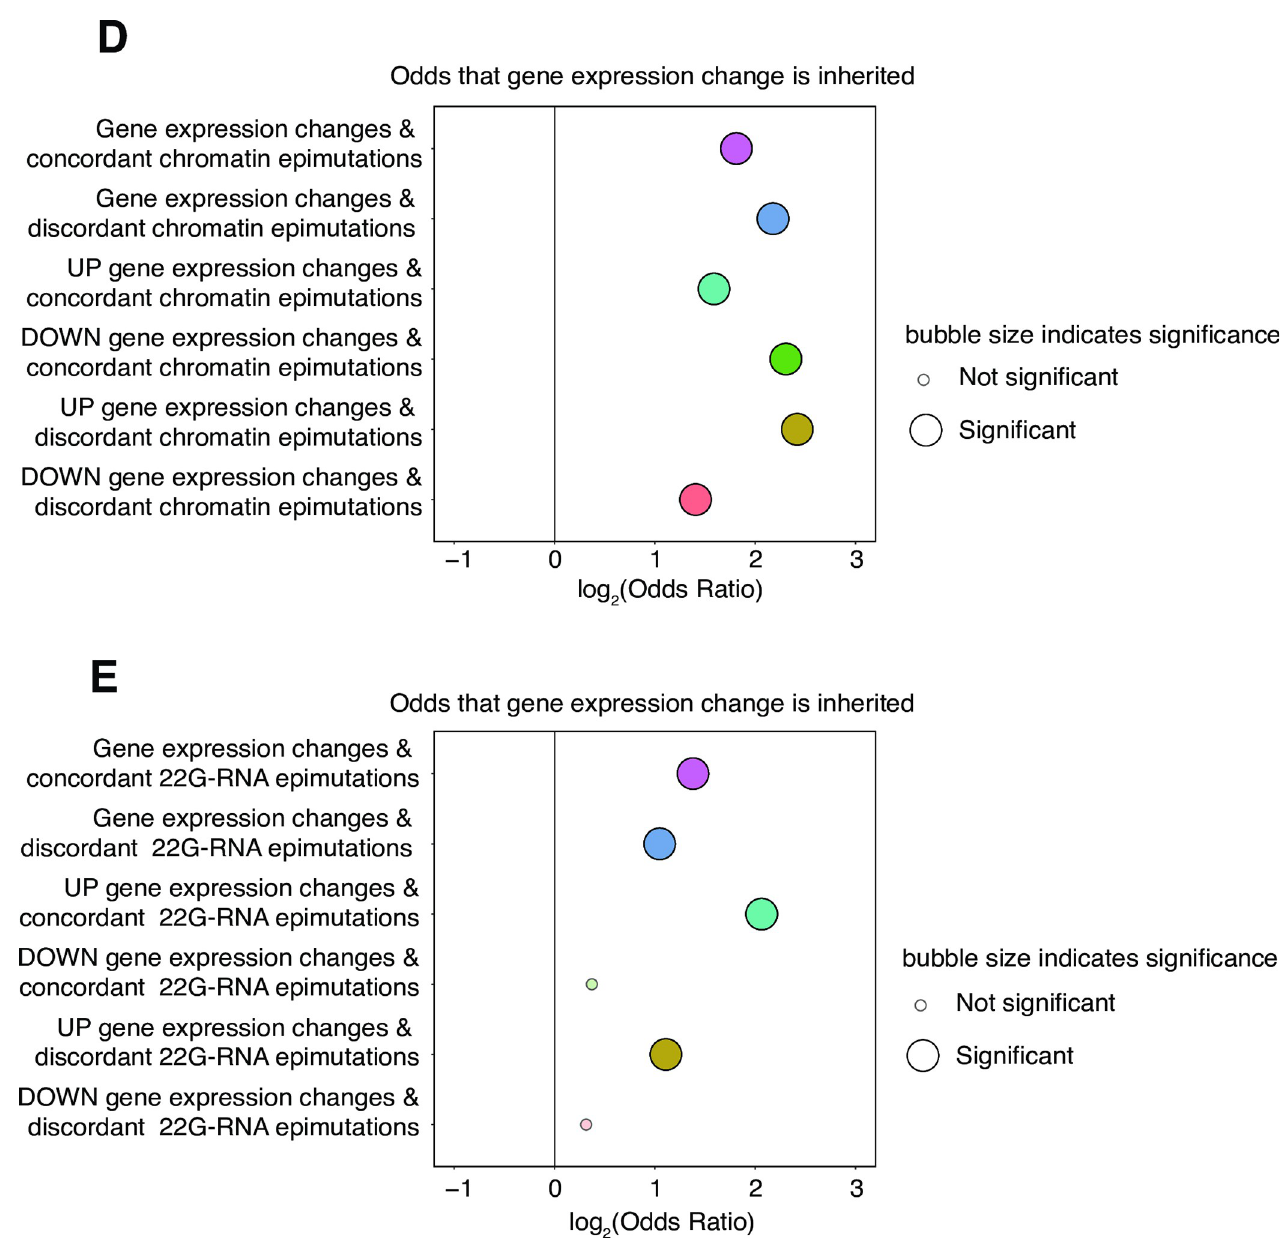
Fig 3. Genes with inherited expression changes are enriched for simultaneous chromatin-based epimutations. A. Chromatin-based epimutations which alter accessibility of regulatory elements to transcription factors (TF) and simultaneous gene expression changes may be inherited in parallel. B. Stacked bar- plot showing proportions of inherited (left bar) and non-inherited (right bar) gene expression changes accompanied by simultaneous chromatin-based epimutations which may themselves be inherited (pink) or non-inherited (blue). C. Stacked bar-plot showing proportions of inherited (left bar) and non- inherited (right bar) gene expression changes accompanied by simultaneous 22G-RNA-based epimutations which may themselves be inherited (blue) or non- inherited (beige) . D. Examination of concordance (simultaneous and direction matched) of gene expression changes and chromatin-based epimutations. Y- axis shows associations tested. X-axis shows log 2 (Odds) of gene expression changes within each association being inherited. Odds ratios and p-values calculated with Fisher’s Exact Test. E. Examination of concordance (simultaneous and direction matched) of gene expression changes and changes in 22G-RNAs. Y-axis shows associations tested. X-axis shows log 2 (Odds) of gene expression changes within each association being inherited. Odds ratios and p-values calculated with Fisher’s Exact Test. p-value cut off for significance is 0.1.